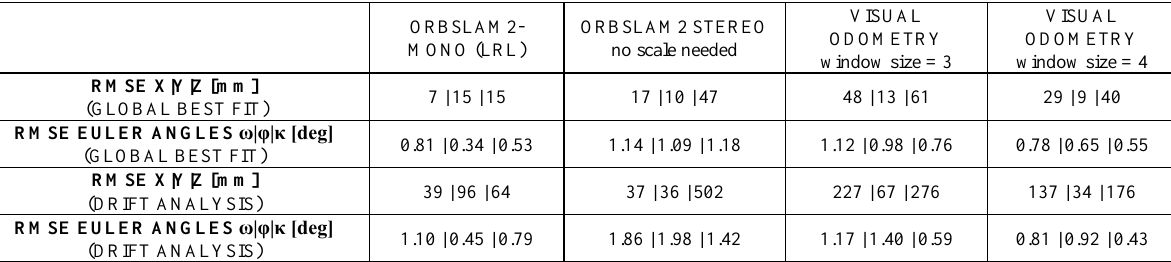
Table 3. Results of the accuracy assessment for the different tested algorithms.